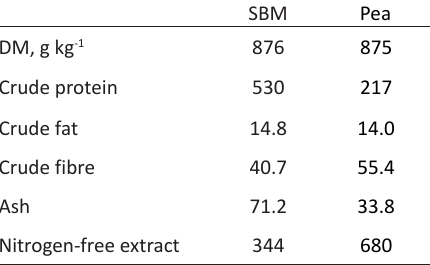
Table 3. Analysed chemical composition of SBM